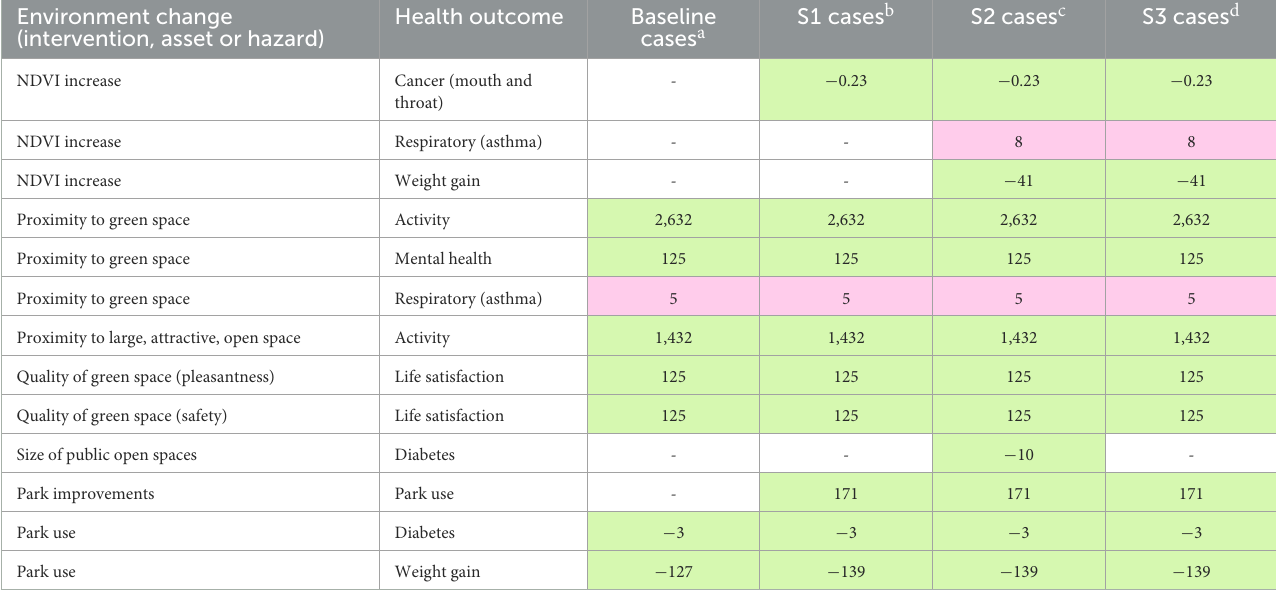
TABLE 3 Net attributable health risks and benefits affected by green space: Baseline and scenarios 1–3 compared. Environment change (intervention, asset or hazard)